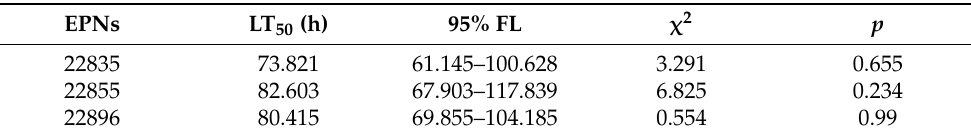
FL: fiducial limits. Corrected mortality was used to calculate LT 50